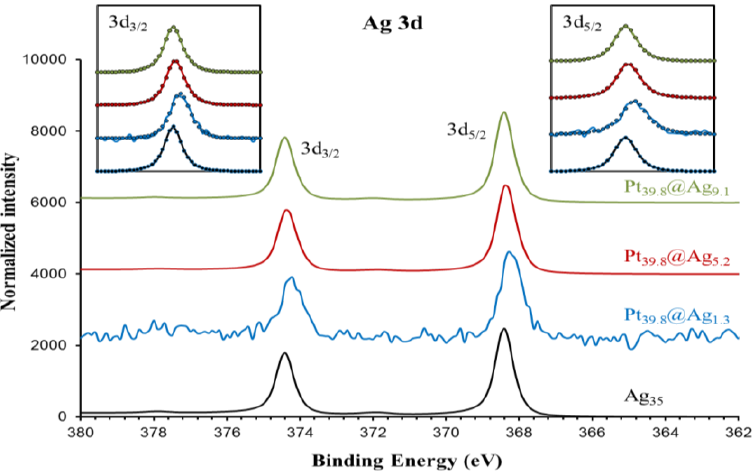
@Ag particles 39.8 y